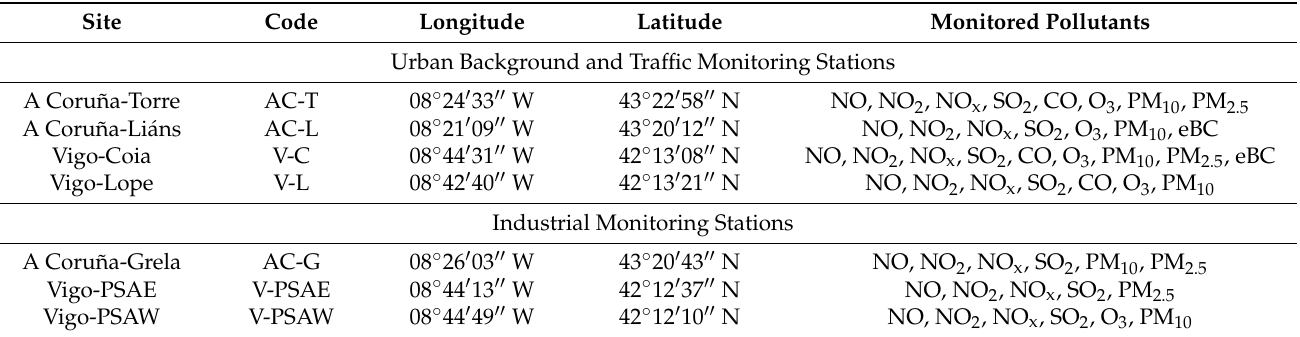
Table 1. Air quality monitoring stations by longitude and